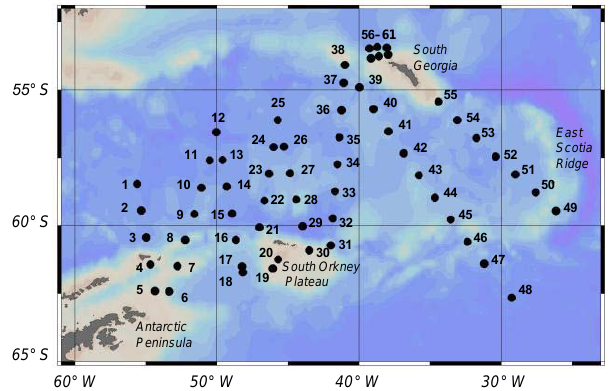
Figure 1. Scotia Sea and South Georgia: sampling locations during austral summer 2003. The date of sampling progressed from 9 Jan- uary (station 1) to 16 February (station 61). Shelf areas ( ≤ 1000m) are presented in light brown